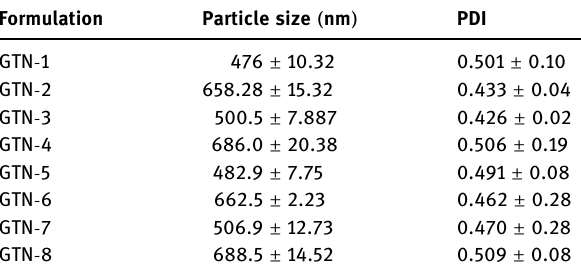
Table 2: Physicochemical characteristics of the prepared glutathione - loaded niosomes Formulation